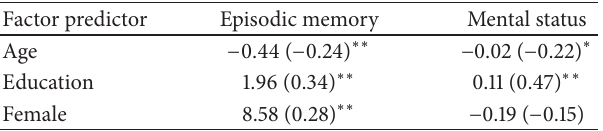
Table 5: Parameter estimates for prediction of two factors (stan- dardized estimates in